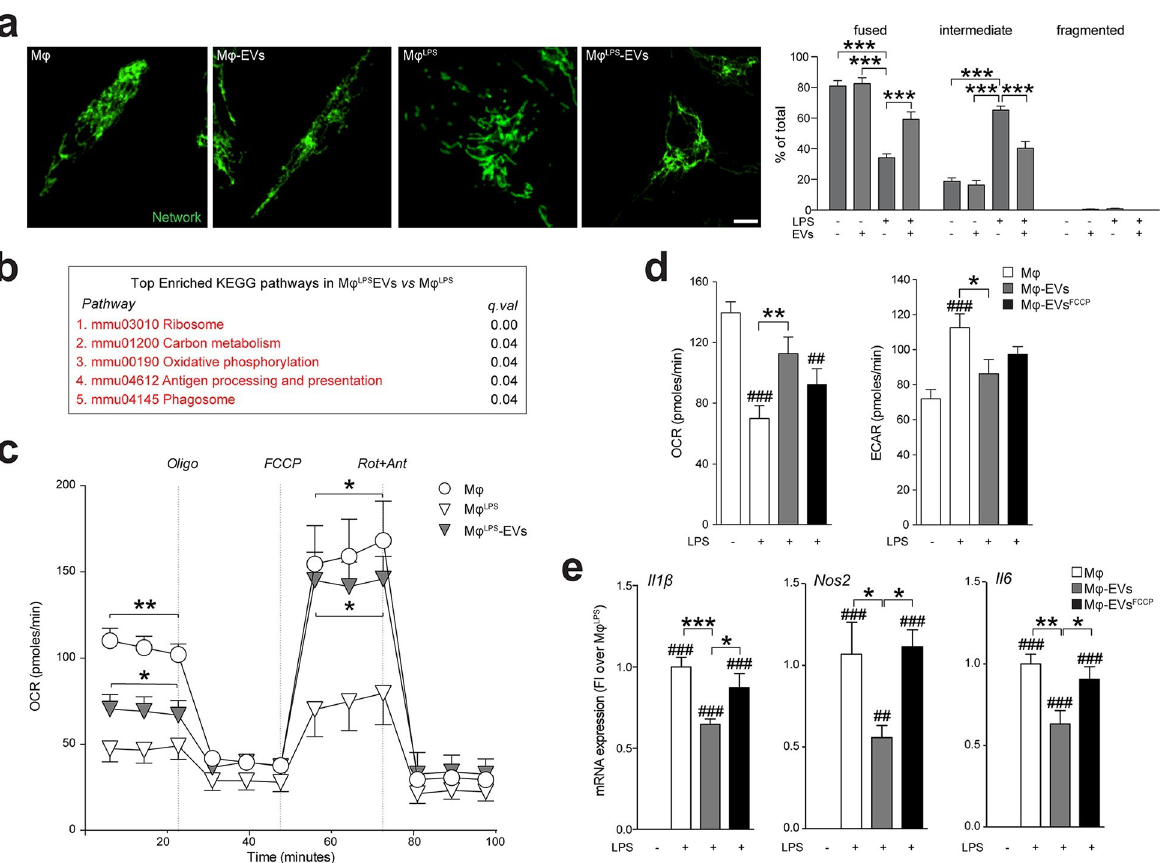
Fig 8. The transfer of EV-associated mitochondria inhibits the metabolic switch of pro-inflammatory mononuclear phagocytes. (a) Representative spinning disk images and quantification showing M φ mitochondrial network labelled with TOMM20 (green) polymorphic dynamics after LPS stimulation and/or EV treatment (1:30). Data are expressed as mean % ( ± SEM). ��� p < 0.001. N = 6 biological replicates. Scale bars: 4 μ m. (Data available in S3 Data). (b) Top enriched KEGG pathways in genes up-regulated in EV-treated vs. untreated M φ LPS at 6 hours. Expression data obtained by microarray analysis. (Data available on ArrayExpress, identifier E-MTAB-8250). (c) XF assay of the OCR during a mitochondrial stress protocol of M φ LPS at 6 hours from EV treatment (1:30). Unstimulated M φ were used as controls. Data are mean values ( ± SEM). � p < 0.05, �� p < 0.01 vs. M φ LPS . N = 2 independent experiments. (Data available in S3 Data). (d) XF assay of the basal OCR and ECAR of M φ LPS at 6 hours from treatment with EVs or treatment with EVs preexposed to the uncoupling agent FCCP vs. M φ LPS . Unstimulated M φ were used as controls. Data are mean values ( ± SEM). ## p < 0.01, ### p < 0.001 vs. unstimulated M φ . � p < 0.05, �� p < 0.01. N � 4 technical replicates from N � 2 independent experiments. (Data available in S3 Data). (e) Expression levels (qRT-PCR) of pro-inflammatory genes ( Il1 β , Nos2 , and Il6 ) in M φ LPS at 6 hours from treatment with EVs or treatment with EVs preexposed to the uncoupling agent FCCP. Data are mean FI over unstimulated M φ ( ± SEM). ## p < 0.01, ### p < 0.001 vs. unstimulated M φ . � p < 0.05, �� p < 0.01, ��� p < 0.001. N � 3 biological replicates from N � 2 independent experiments. (Data available in S3 Data). ECAR, extracellular acidification rate; EV, extracellular vesicle; FI, fold induction; KEGG, Kyoto Encyclopedia of Genes and Genomes; LPS, lipopolysaccharide; OCR, oxygen consumption rate; qRT-PCR, quantitative real-time polymerase chain reaction; XF, extracellular